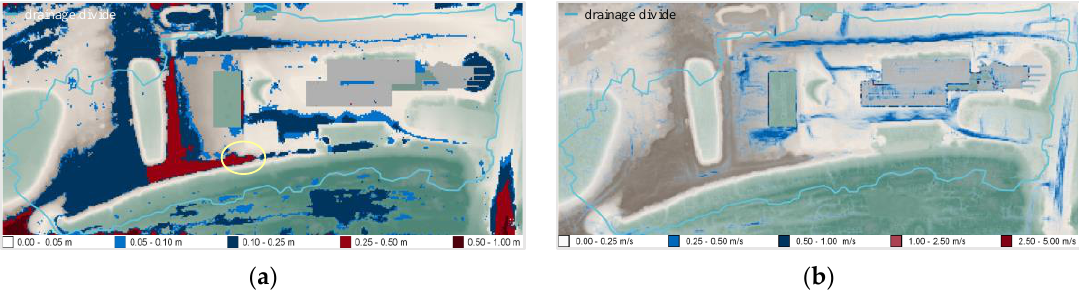
Figure 13. ( a ) Flood hazard map of understudy watershed for a 100-year rain event with a duration of one hour generated by LISFLOOD-FP; ( b ) maximum predicted water velocities for a 100-year rain event.